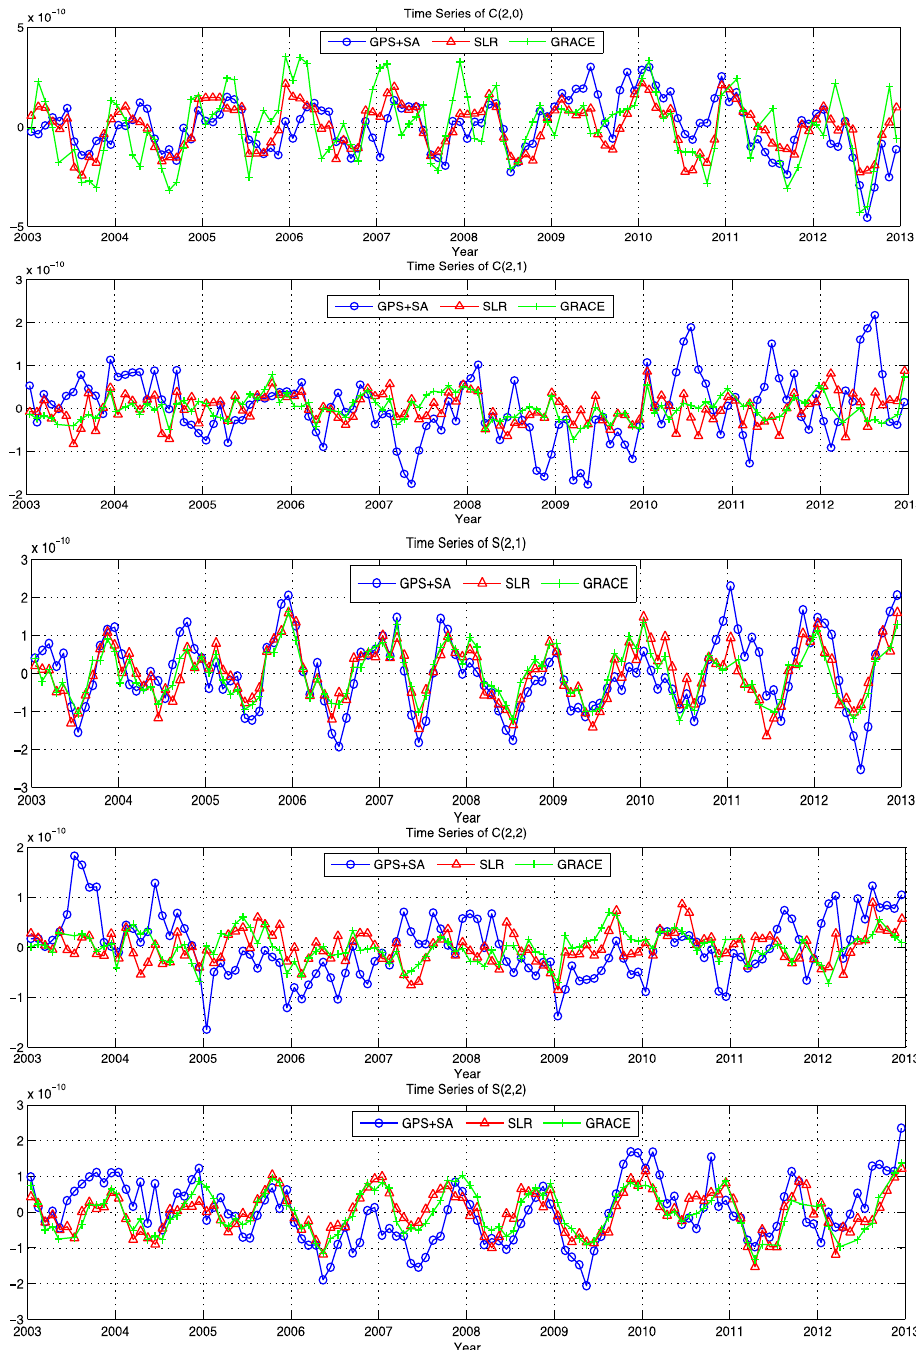
Figure 5. Time series of time-varying degree-2 gravity coefficients estimated from GPS+SA, SLR and GRACE. GPS+SA shows the results from combining GPS and SA with the truncation degree at 60. GRACE results are from the CSR RL05 product. SLR results are from [9,10]. Figures from the top to bottom are time series of C20, C21, S21, C22 and S22 respectively.